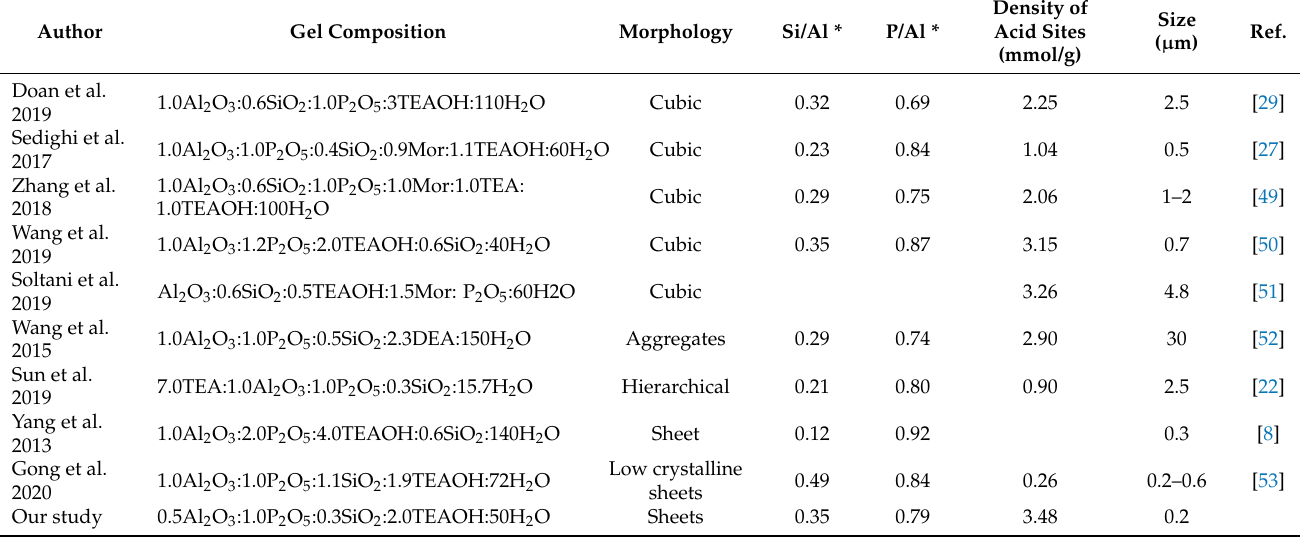
Table 5. A comparison of various reported SAPO-34 particles and their characteristics.